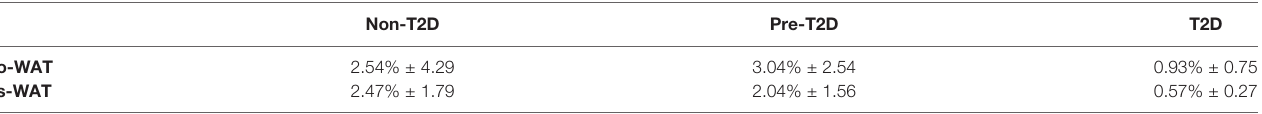
TABLE 3 | Proportion of mast cell progenitors in the whole mast cell pool.